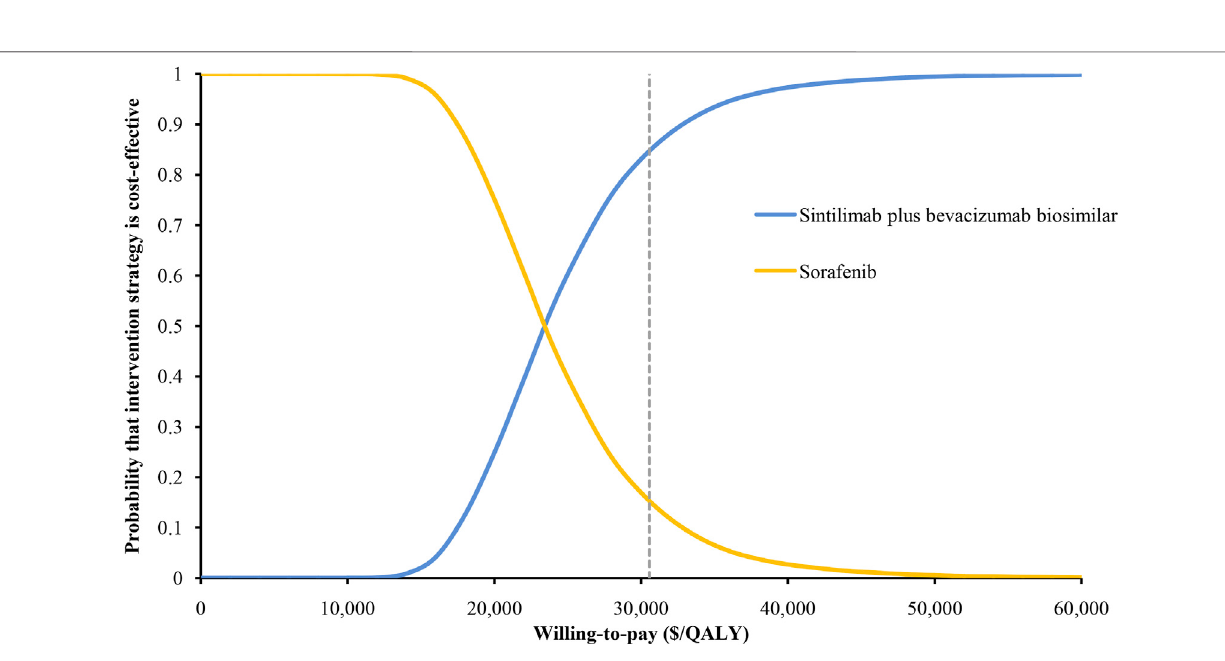
Frontiers in Pharmacology |